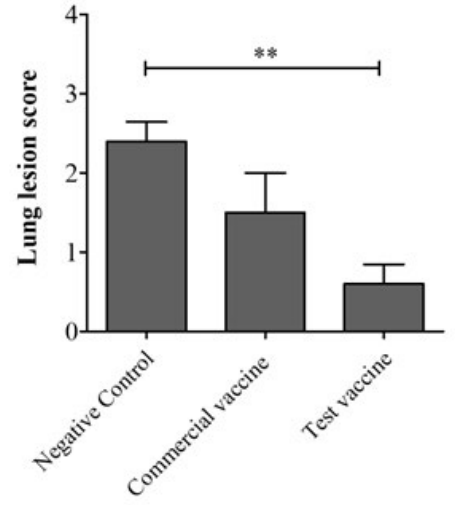
Fig. 4. Lung lesion scores of pigs vaccinated with the test vaccine, the commercial vaccine, or PBS after challenge with virulent App strains. Data are presented as means ± SD. The asterisks indicate significant differences. ** p <